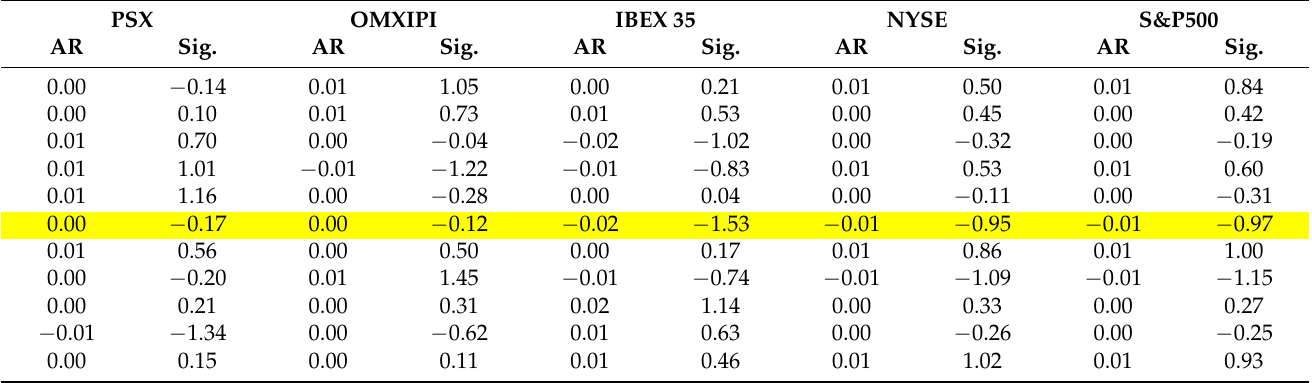
Table A13. Abnormal returns of the ( − 5, +5) event window (Prime Minister of Iceland Announced His Resignation).